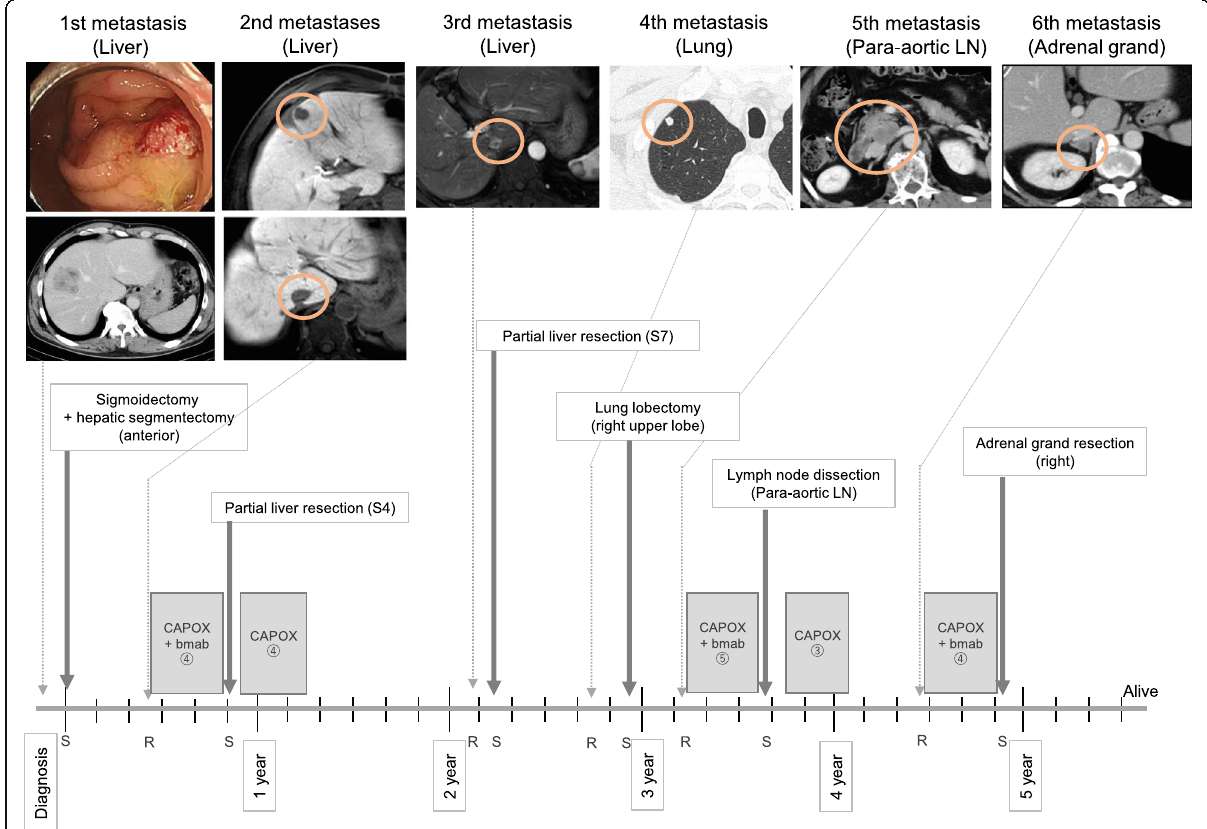
Fig. 2 Clinical course of the patient ’ s metastases, surgeries, and other anticancer treatments. S, surgery; R, detection of